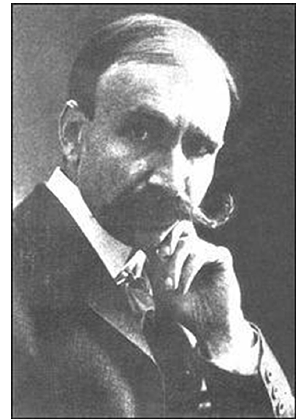
Figure 1. Photo of Maurycy Pius